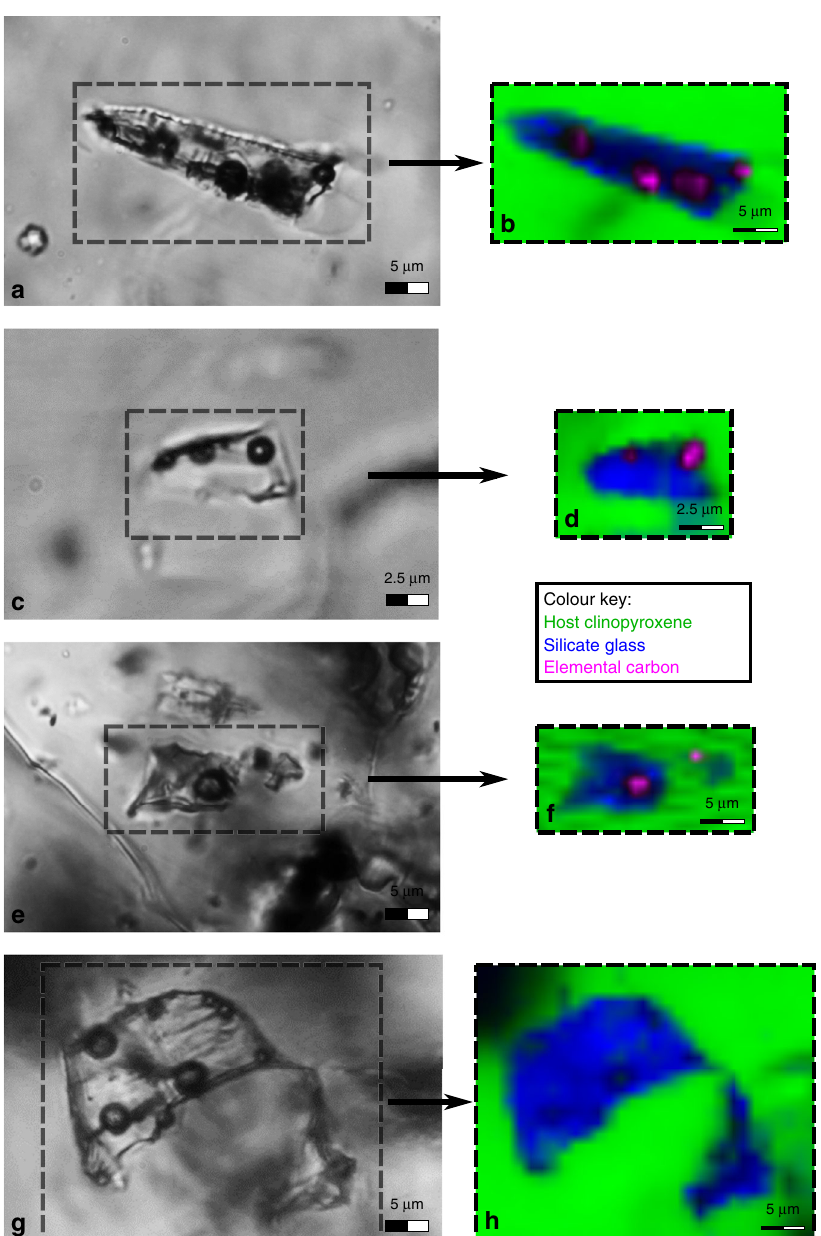
Fig. 4 Bubble-bearing melt inclusions at transmitted light optical microscopy and confocal Raman microspectroscopy. Left column: transmitted light photomicrographs at optical microscope of the analysed areas, bordered by dotted lines. Right column: Raman hyperspectral maps of the corresponding areas. a , c , e Photomicrographs of elemental carbon-bearing single- and multi-bubble MIs ( a and c : sample NEW31, New Jersey, USA; e : sample AN39, Morocco). b , d , f Raman hyperspectral maps of the same samples area. g Photomicrograph of an irregular-shaped CO 2 -bearing multi-bubble MI (sample NS12, Nova Scotia, Canada). h Raman hyperspectral map of the same sample area. The Raman signal of CO 2 is weak due to its low density. However, spot analyses con fi rmed the presence of CO 2 in all host clinopyroxene crystal clots can be calculated from mineral compositions (Supplementary Table 6) using methods devel- oped for magmatic systems 37,38 (Supplementary Note 2). The geothermobarometer based on the equilibrium between clinopyr- oxene and a magmatic liquid 37 was applied using whole rock composition as proxy for the original magmatic liquid composi- tion, because the MIs glass is in chemical disequilibrium with the host clinopyroxene. The calculated crystallization pressure ranges from 0.1 to 0.7 ± 0.2 GPa (at temperatures from 1150 to 1230 ± 27 °C) and is consistent with previous estimates from clinopyr- oxene crystallization pressures (from 0.2 to 0.8 GPa) in basalts